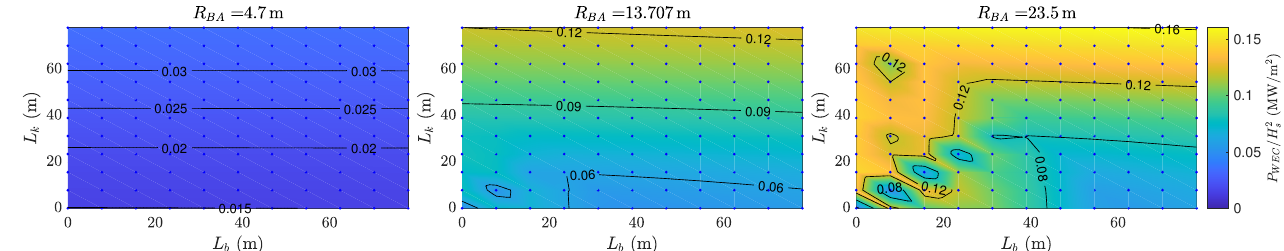
Figure 6. Power generated as a function of L k and L b for tests with, D BA / R BA = 1.00, T p = 12s, and ∆ x = 50m. Left to right: varied values of BA radius.